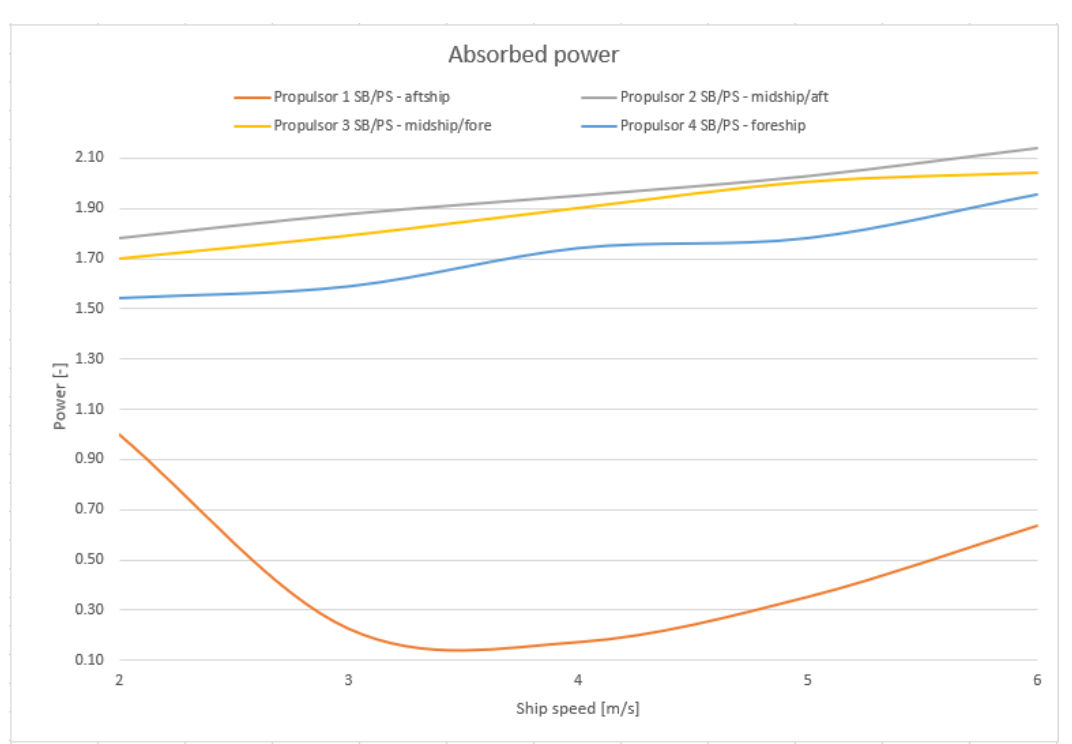
Figure 13. Propulsion power, shallow water (layout E). Source: Authors.